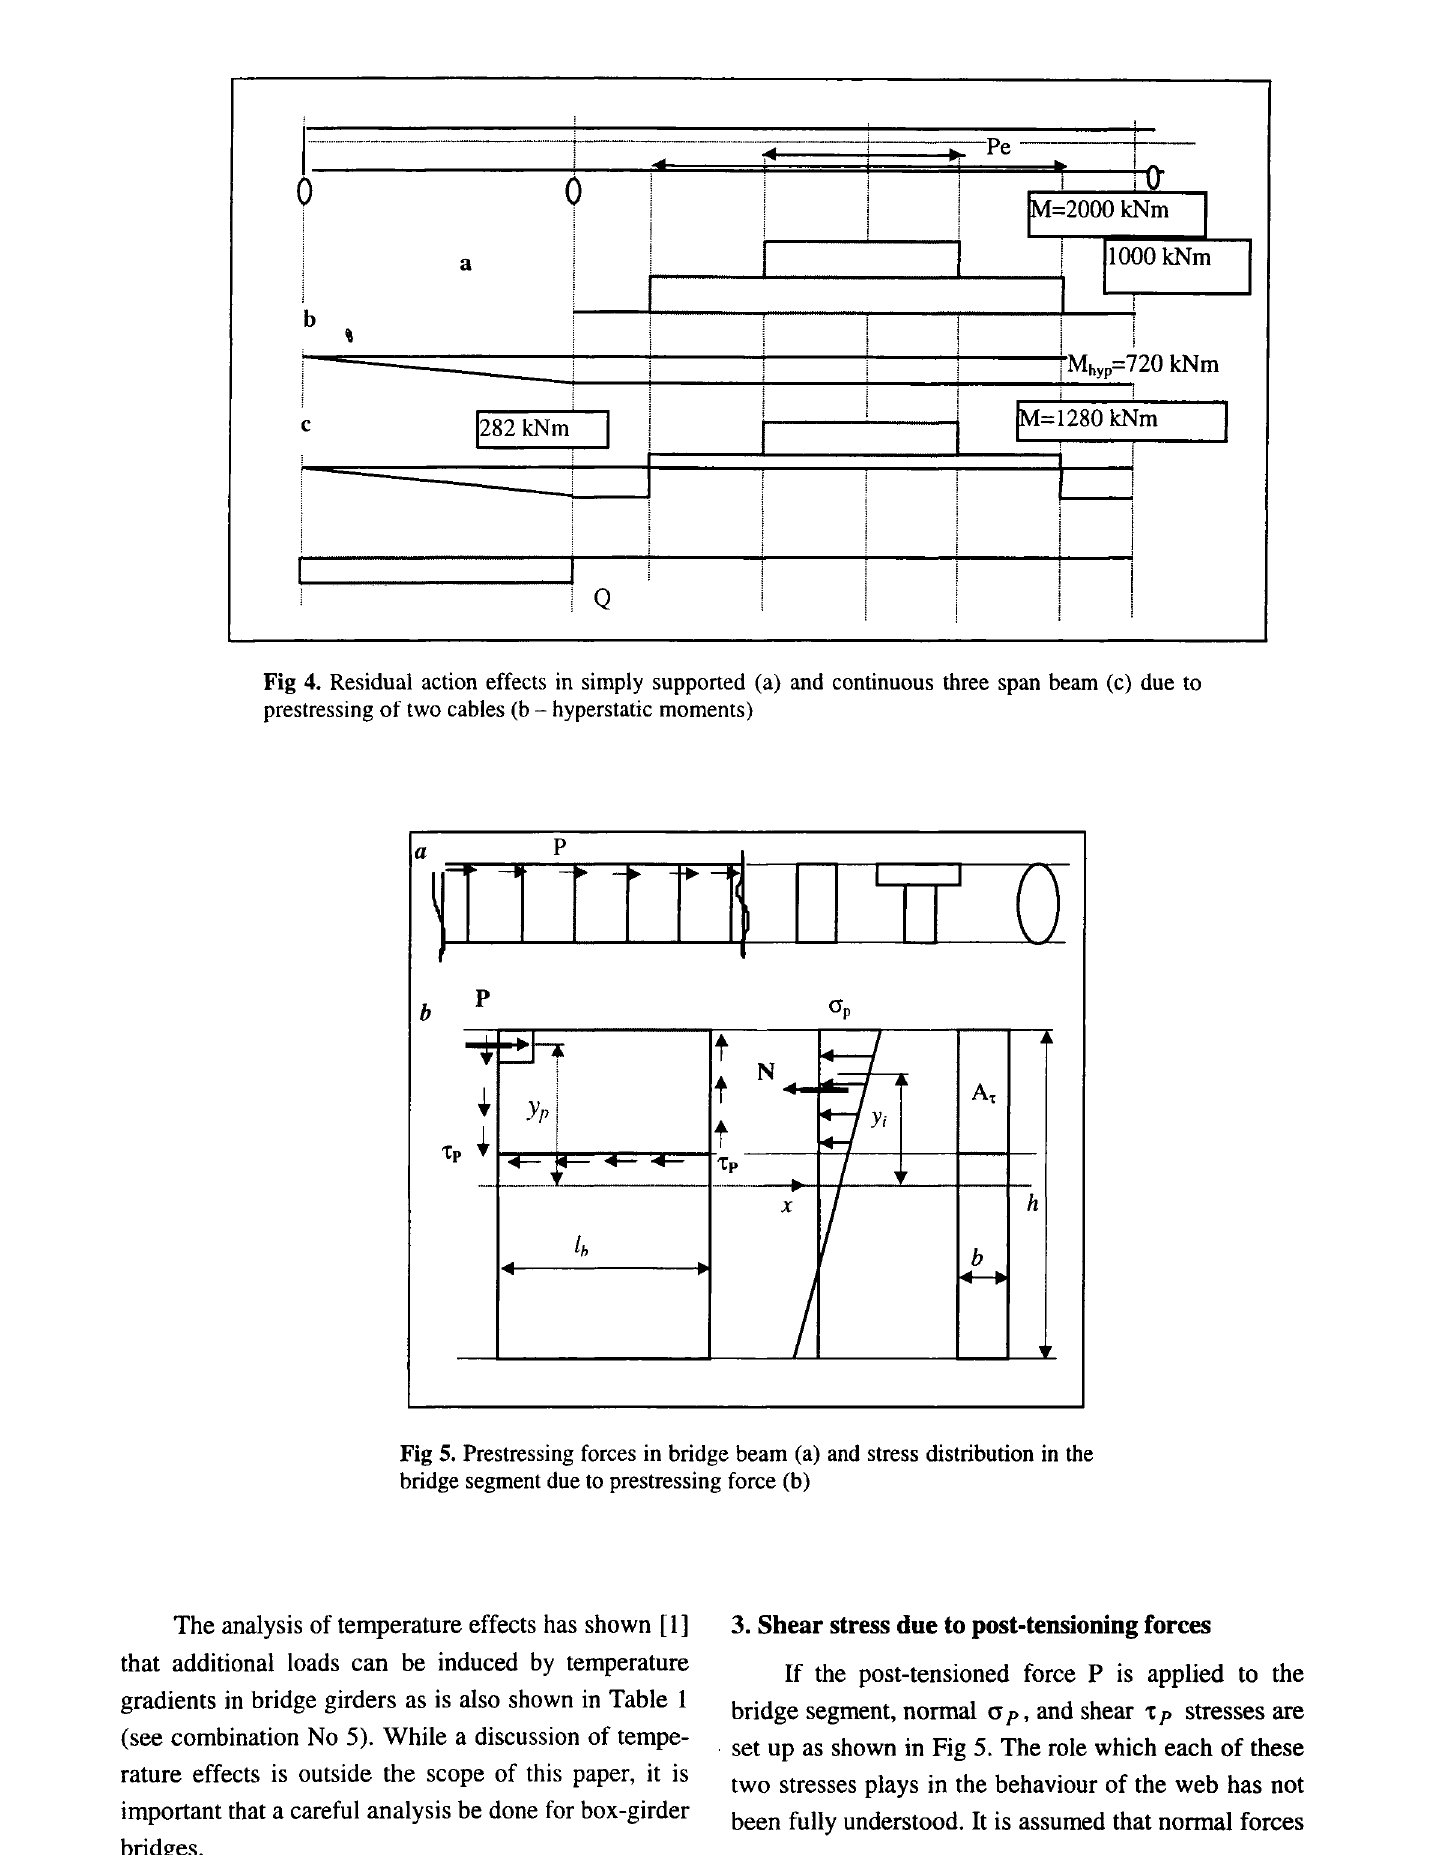
Fig 5. Prestressing forces in bridge beam (a) and stress distribution in the bridge segment due to prestressing force